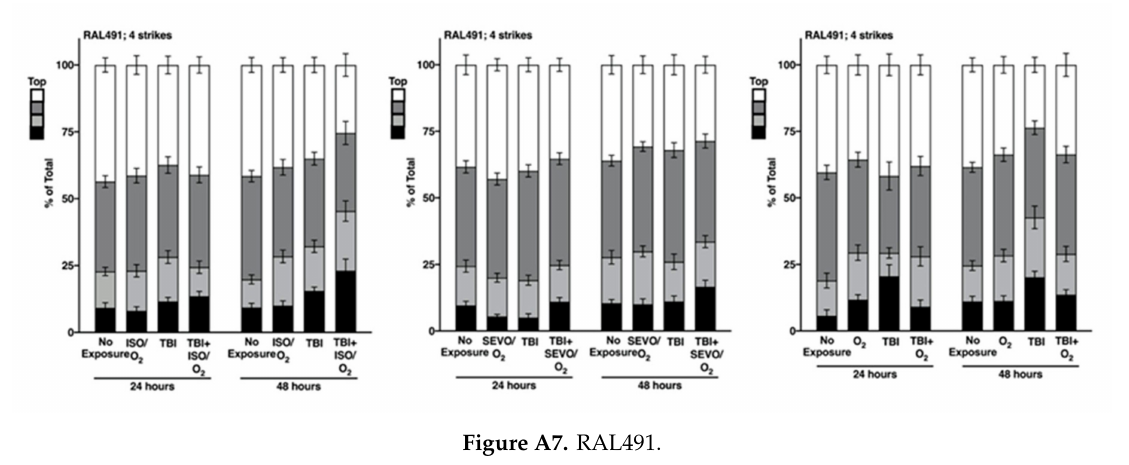
Figure A7. RAL491.